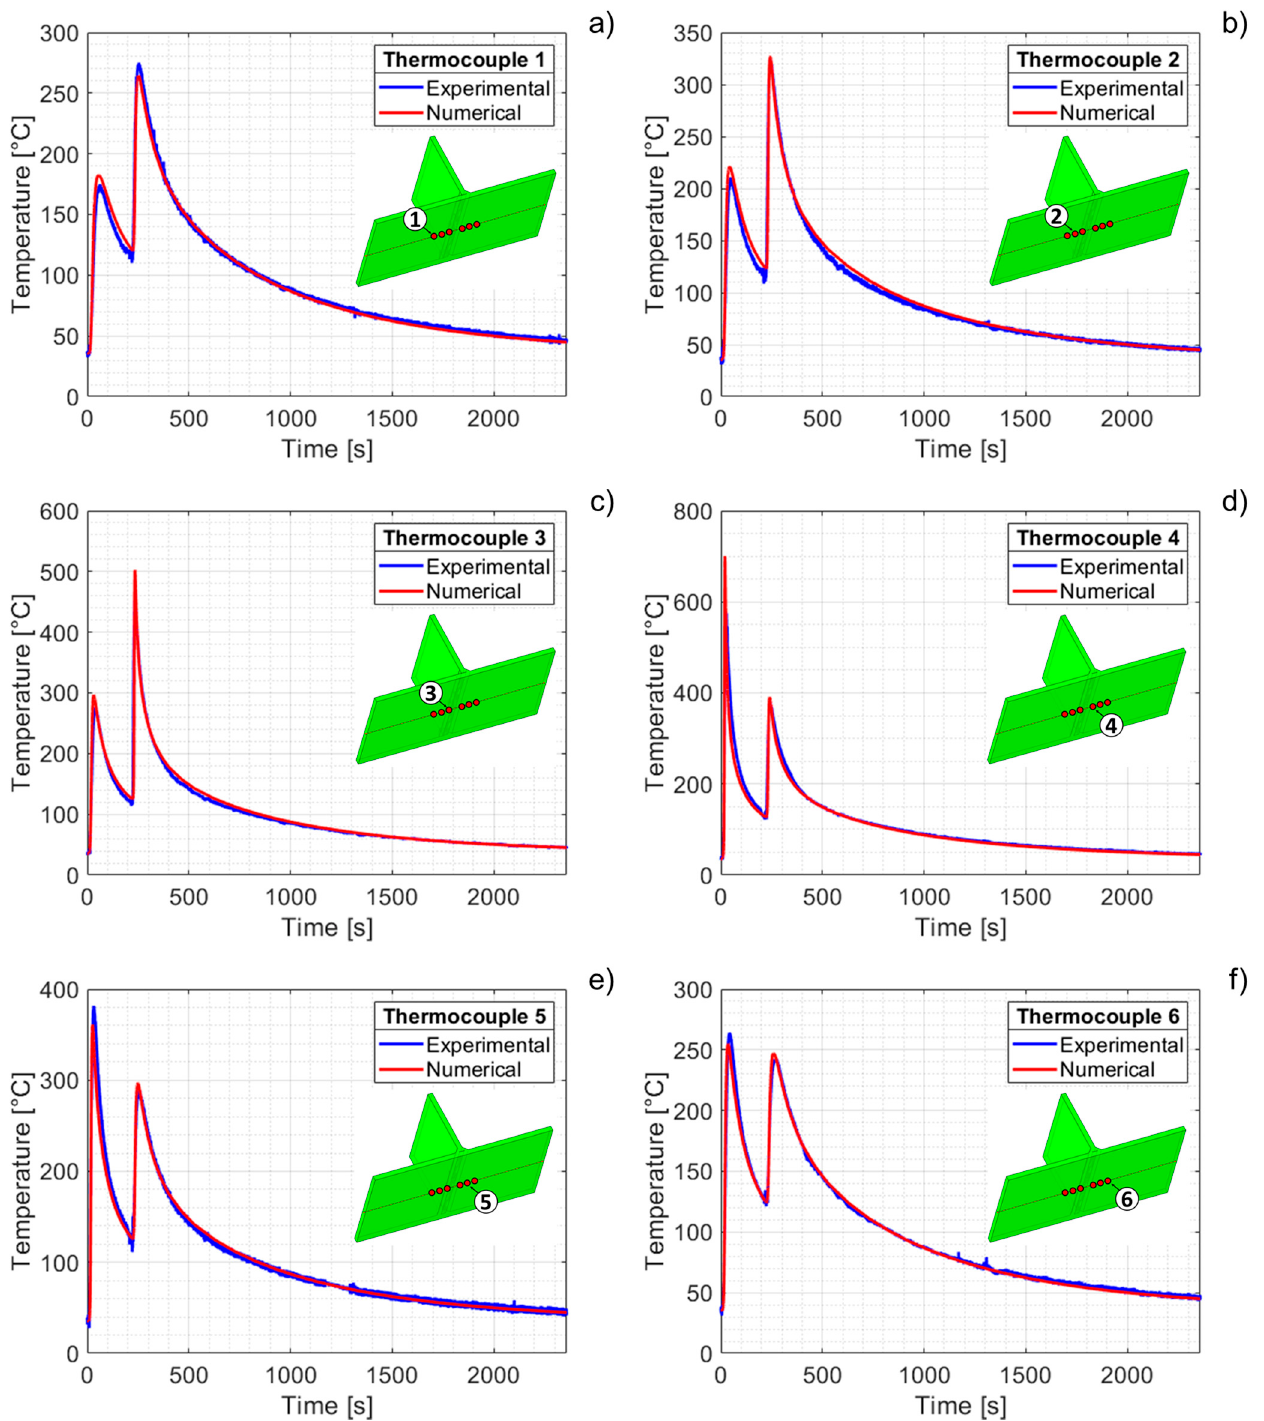
Figure 9. Experimental vs. numerical temperature distributions at the thermocouples locations on the flange: ( a – f ) for thermocouple positions 1–6.